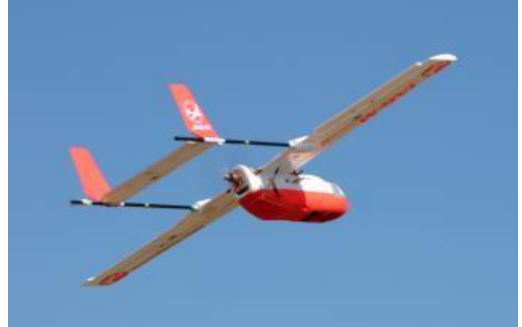
Figure 3. The JAG-M fixed-wing